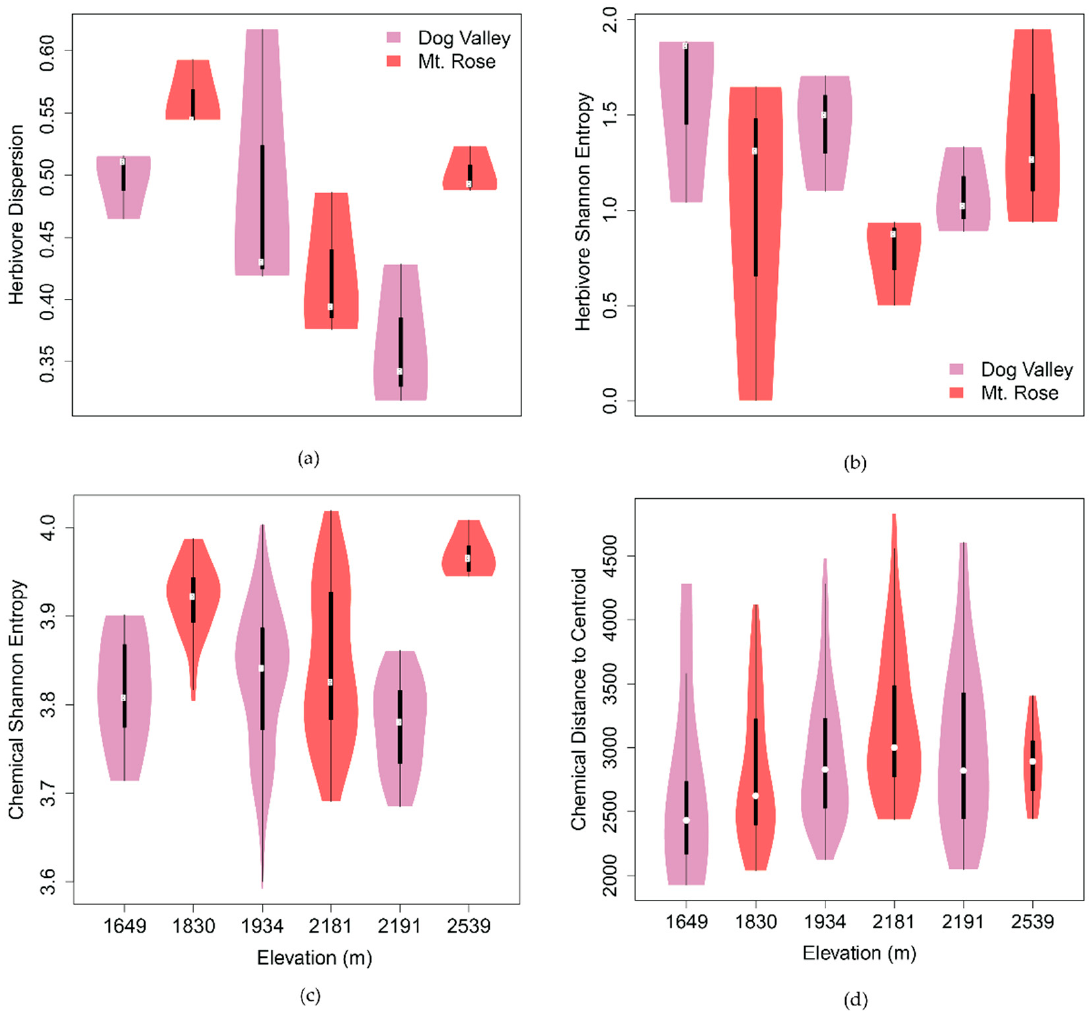
Figure 2. Subsite-level dispersion and diversity across elevation of herbivores and phytochemistry of C. velutinus communities. ( a ) Inter-plot herbivore dispersion (ANOVA 5,12 ; p < 0.05) differed significantly among subsites, while ( b ) mean plot herbivore diversity (Shannon entropy; ANOVA 5,12 ; p = 0.37) did not. ( c ) Phytochemical diversity (ANOVA 5,295 ; p < 0.001) and ( d ) dispersion (ANOVA 5,295 ; p < 0.05), aggregated by month, individual, and plot, varied significantly among subsites. Herbivore dispersion and phytochemical diversity have a sinusoidal relationship with elevation, having a crest at ca. 1830 m and trough at ca. 2191 m. Across elevation, herbivore diversity and chemical dispersion have an inverse mid-domain effect relative to one another, with herbivore diversity having a valley and chemical diversity having a peak at ca. 2200 m a.s.l.